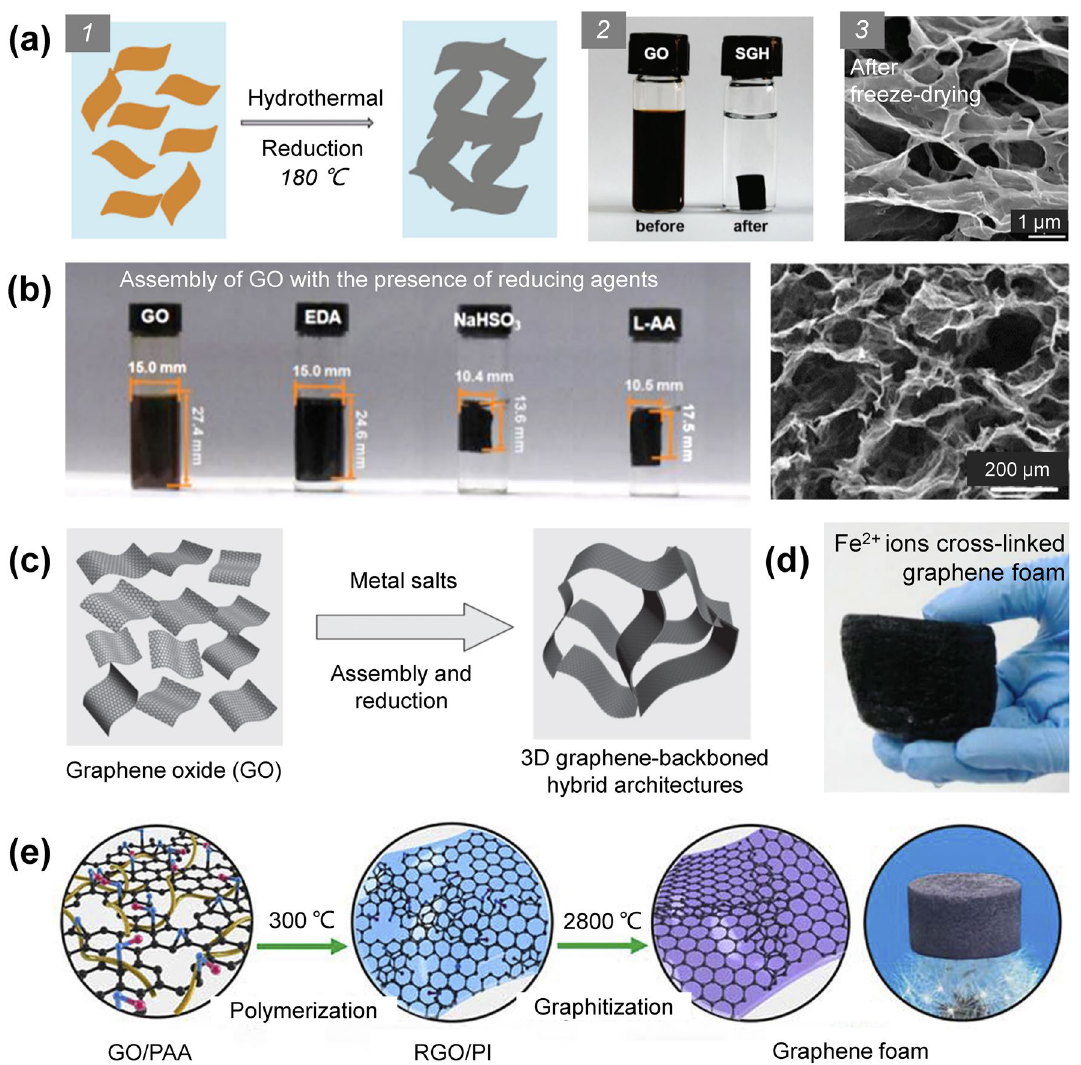
Fig. 7 a Schematic of formation of networks during hydrothermal reduction in microscale, optical photographs of GO suspension and GHs formed by hydrothermal reduction and the scanning electron microscope (SEM) image of the graphene network [123]. b Optical photographs of GO suspension and GHs formed by chemical reduction and the SEM image of the graphene network [124]. c–e Schematics of the microscopic mechanism of the formation of graphene 3D networks induced by adding multivalent metal ions and water‑soluble polymers and optical photo‑ graphs of the graphene foams formed after post‑treatment